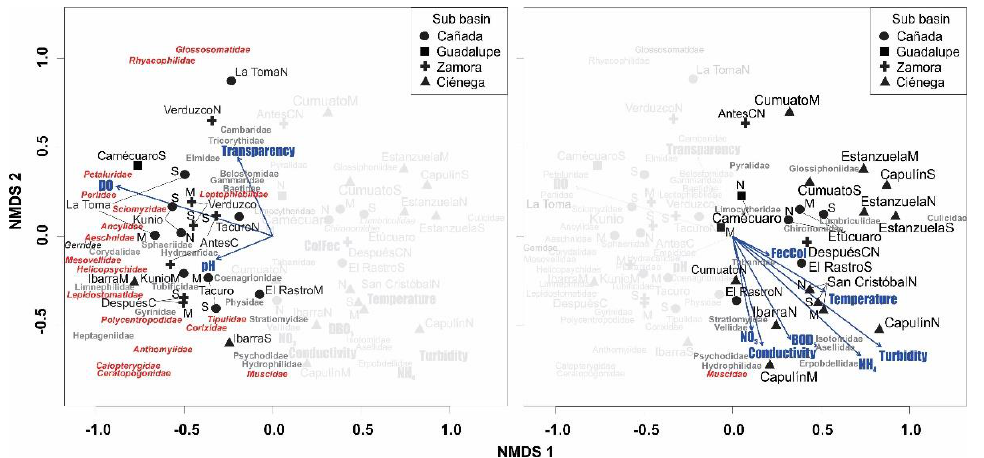
Figure 3. NMDS ordination axes 1 and 2 of the Duero River, including sampling sites within sub- basins, macroinvertebrates families, and environmental variables (stress = 0.14). The same plot is divided into two parts to describe a trend from good ( left ) to poor ( right ) conditions. After the site’s name, the capital letter represents the season (M = May, S = September, and N = November). AntesC = Antes Central de Abastos and DespuésC = Después Central de Abastos. DO = Dissolved Oxygen, FecCol = Fecal Coliforms. Family names in red have high bioindication values (6 to 9), and those in gray have low values (3 to 5).